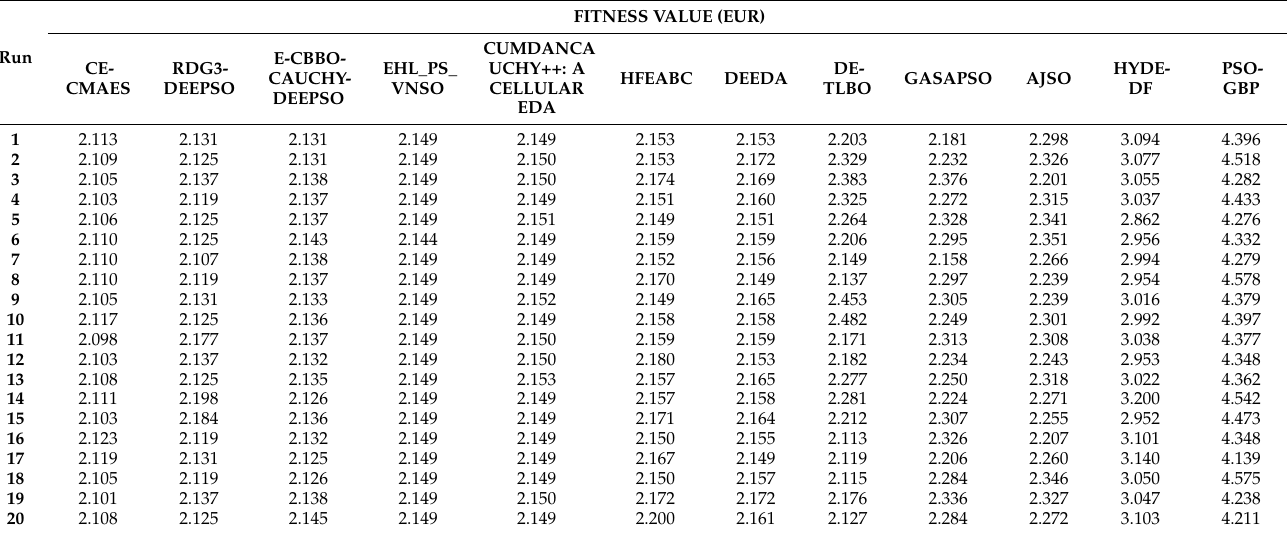
Table 2. Fitness value of the tested algorithms over 20